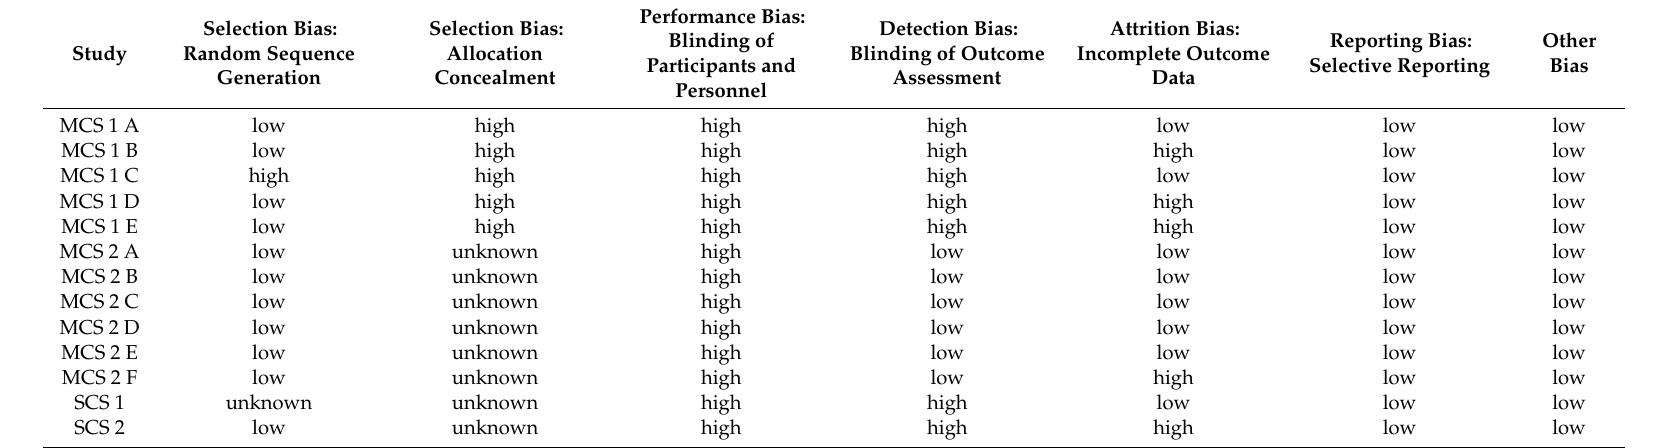
Table 2. Individual studies’ outcomes risk of